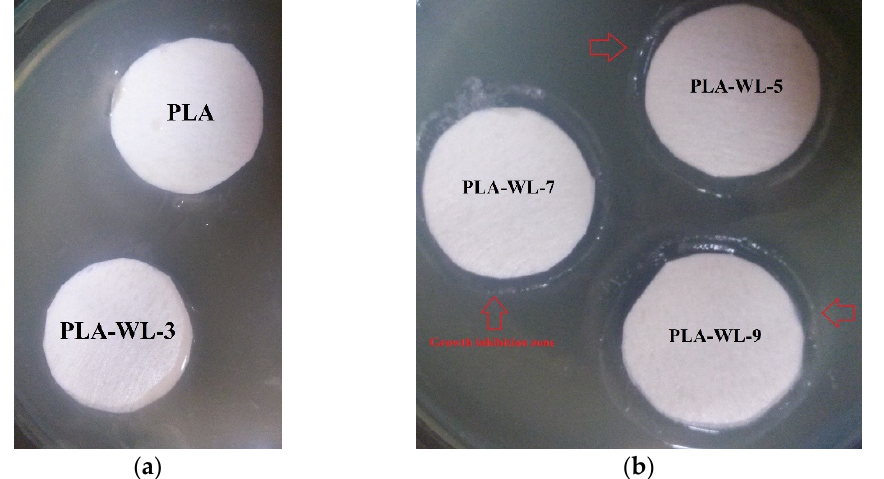
Figure 7. The antibacterial activity of the prepared biocomposites (( a ) PLA and PLA ‐ WL ‐ 3 and ( b ) PLA ‐ WL ‐ 5, PLA ‐ WL ‐ 7, and PLA ‐ WL ‐ 9) against E. coli. ( b ) PLA-WL-5, PLA-WL-7, and PLA-WL-9) against E. coli